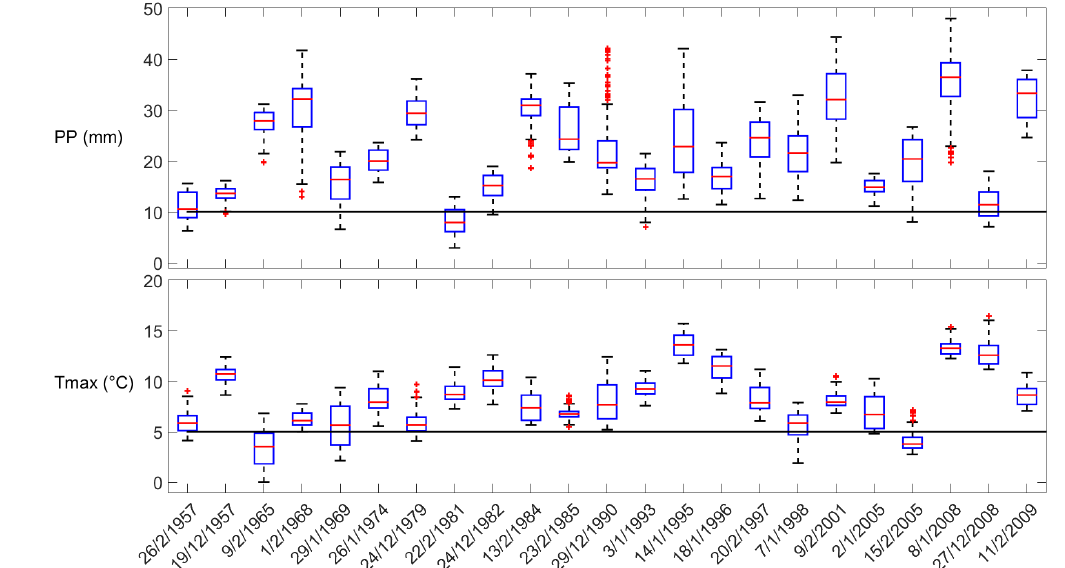
Figure 2. Distribution of NRCANmet temperature and precipitation from all three watersheds grid points corresponding to each DJF high- flow event. Boxes extend from the 25th to the 75th percentile, with a horizontal red bar showing the median value. The whiskers are lines extending from each end of the box to the 1.5 interquartile range. Plus signs correspond to outliers. The horizontal black lines correspond to the thresholds used to define DJF weather extreme